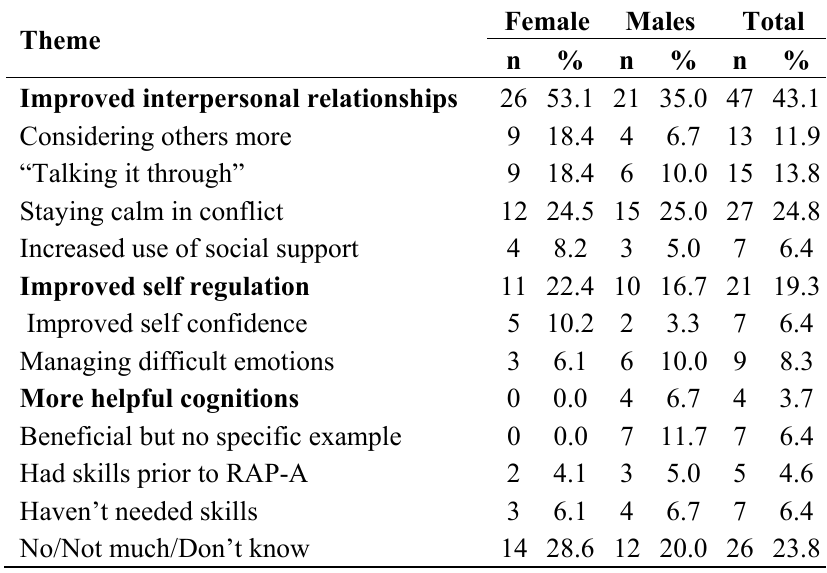
Table 1. Number of interviews with adolescents during which themes were identified as specific outcomes of RAP-A